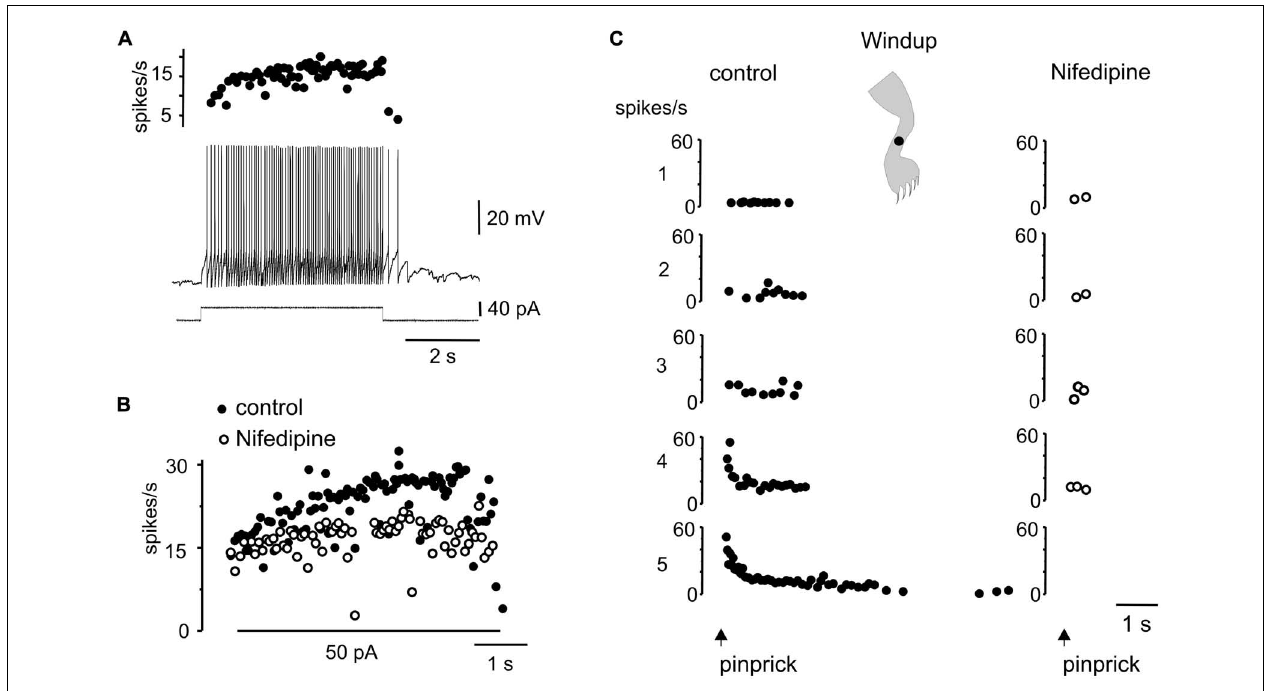
addition of nifedipine (50 μ M). (C) Repeated noxious mechanical stimulation applied in the ipsilateral leg produced a windup of the response in control conditions but not in the presence of nifedipine (50 μ M). All data from the same